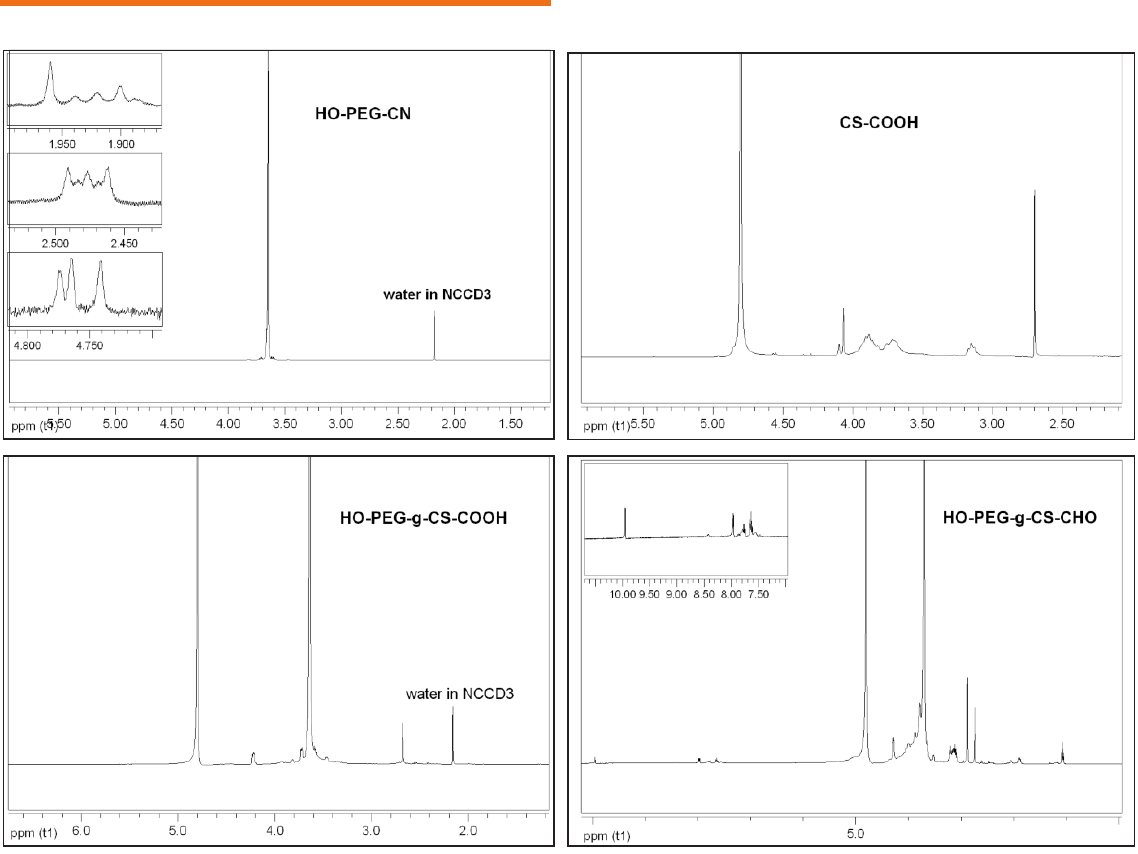
Figure 3. The 1 H NMR spectra of HO-PEG-CN, CS-COOH, HO-PEG-g-CS-COOH, and